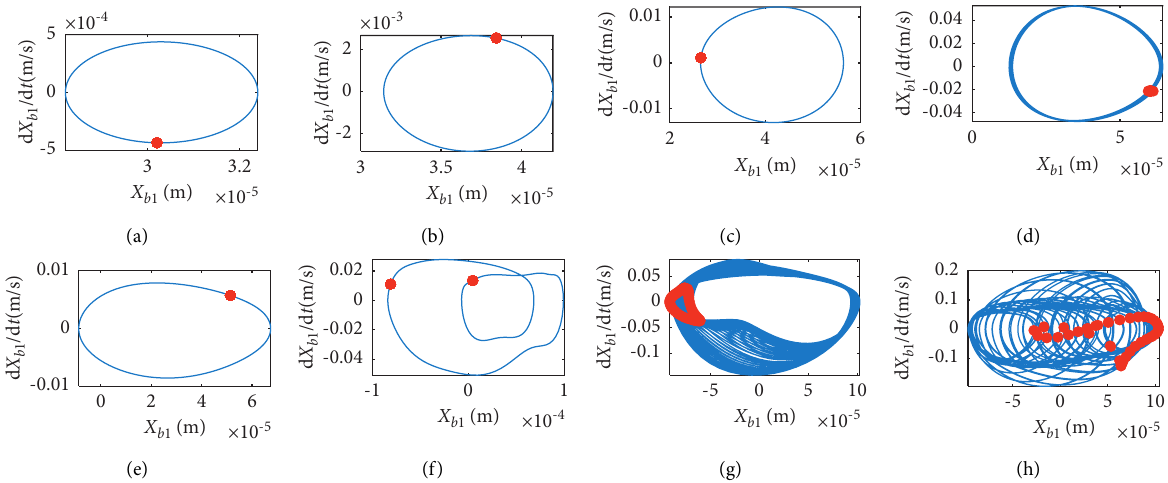
Figure 5: Phase trajectory and Poincare diagram: (a) normal state, 2000rpm; (b) normal state, 5000rpm; (c) normal state, 8000rpm; (d) normal state, 18000rpm; € fault state, 2000rpm; (f) fault state, 5000rpm; (g) fault state, 8000rpm; (h) fault state,